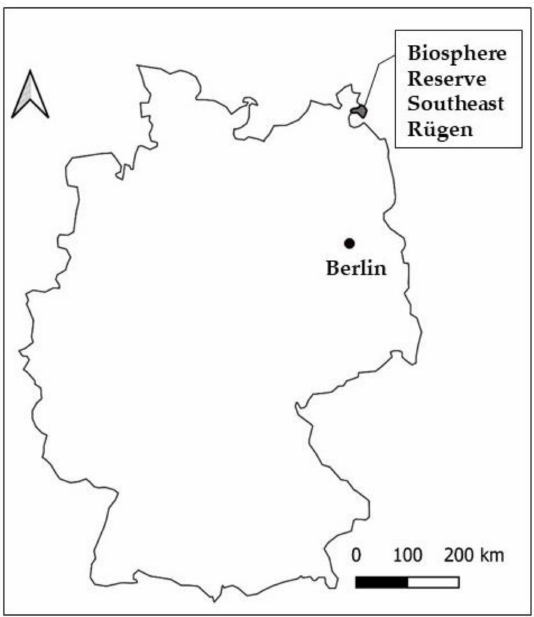
Figure 2. Southeast Rügen Biosphere Reserve in